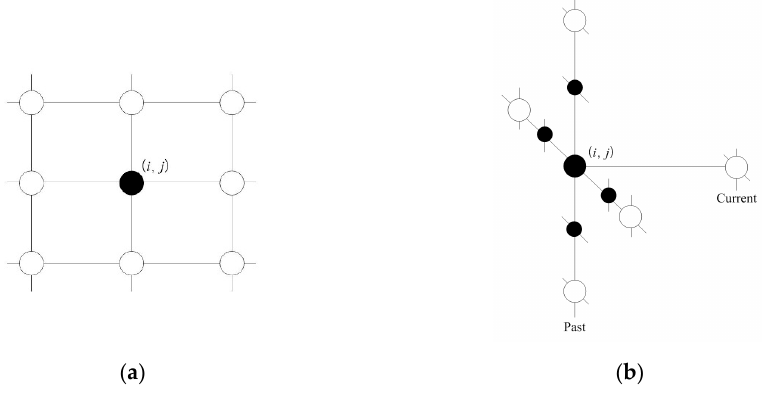
Figure 4. Second–order spatio–temporal neighborhood system: ( a ) spatial domain and ( b ) temporal domain.